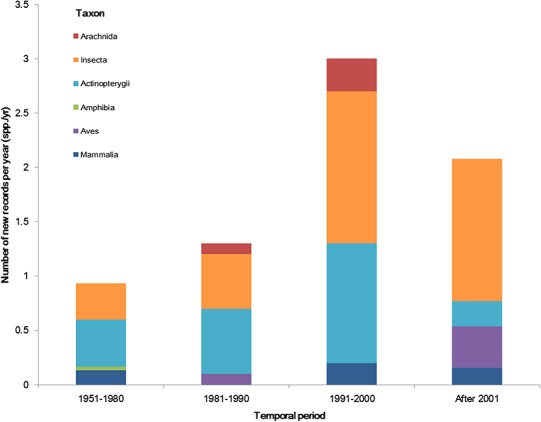
The temporal trend of alien animal species in the past 64 years.We considered the first recorded time of each species to graph the column figure. Species without such data were excluded.